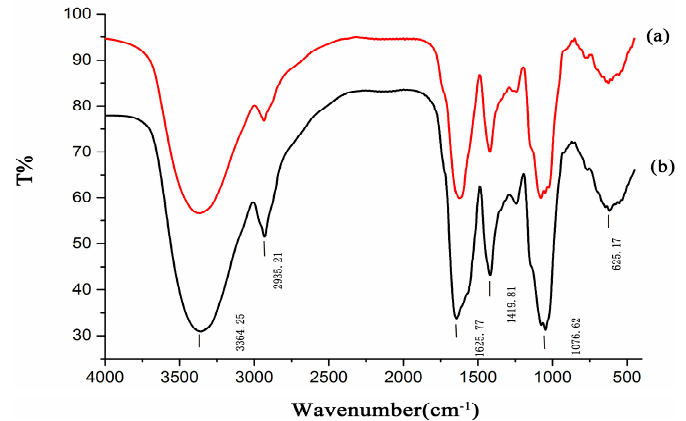
Figure 5. FT-IR spectra of HAPS ( b ) and APS ( a ), the spectral measurement within 4000–450 cm − 1 .